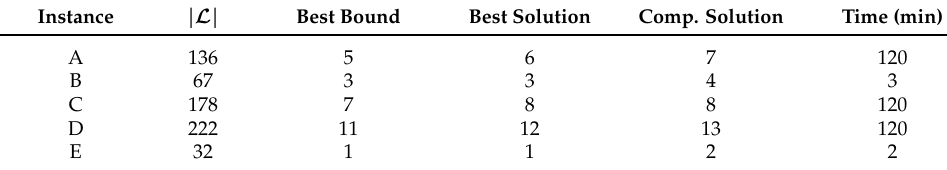
Table 4. Third run for all instances.